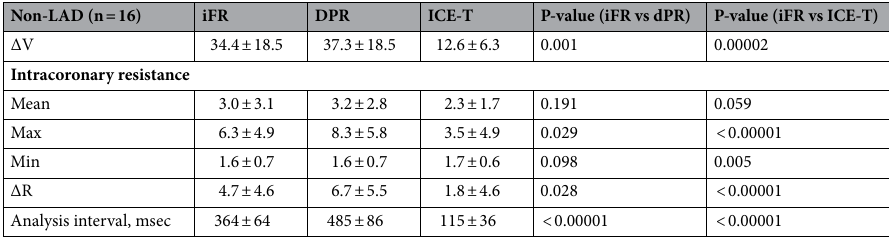
Table 4. A comparison of iFR and ICE-T according to LAD or non-LAD artery measurements and condition (A: rest, B: hyperemia). DPR diastolic pressure ratio, ICE-T intracoronary electrocardiogram-triggered resting index, iFR instantaneous flow reserve, LAD left anterior descending artery, non-LAD left circumflex artery and right coronary